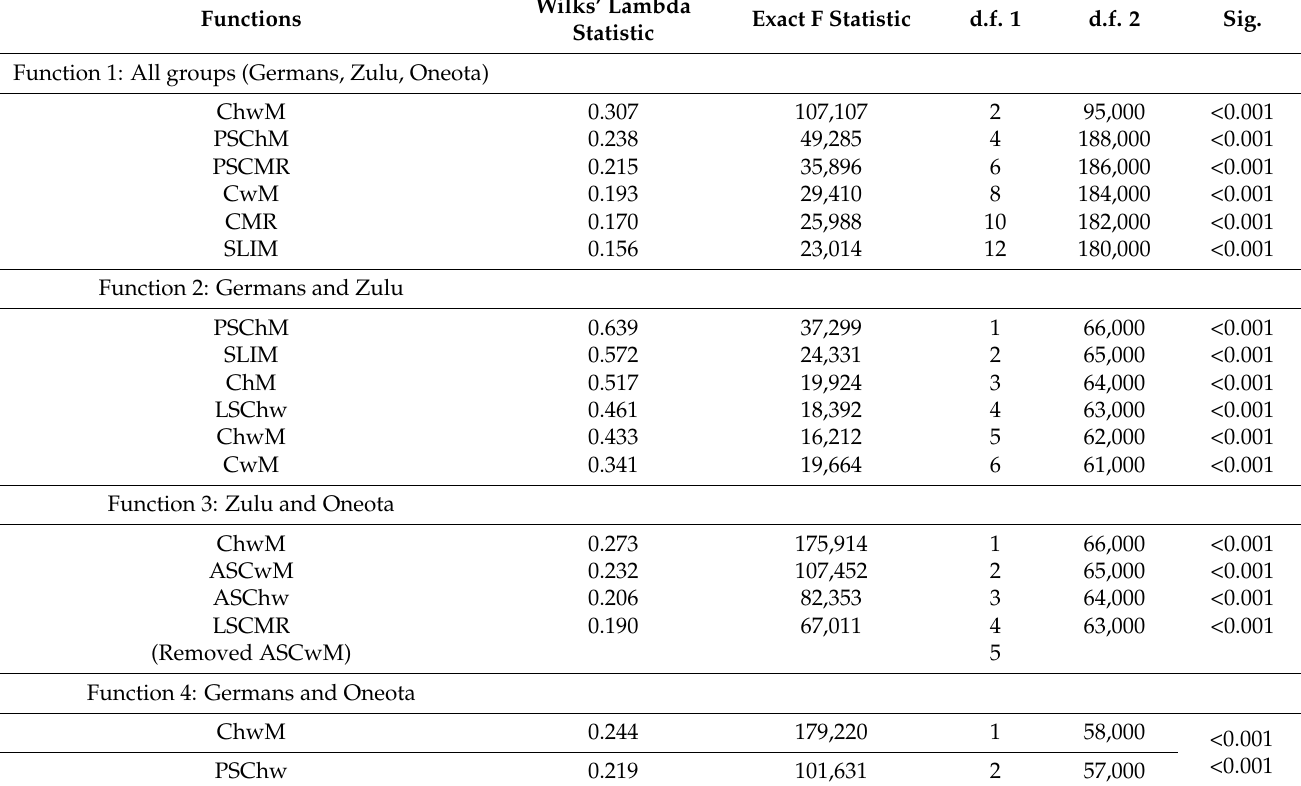
Table 2. Stepwise discriminant function analysis of the bony labyrinth *.